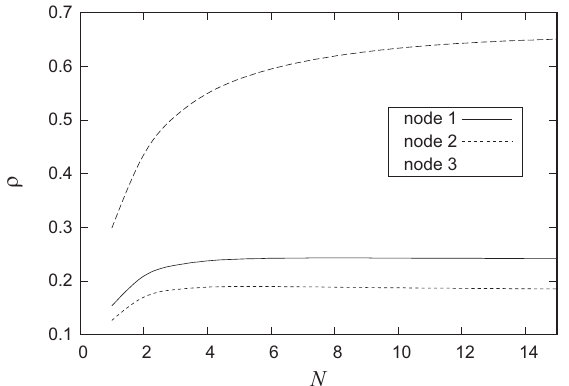
Figure 12. Dependence of the load of the nodes on the parameter N .